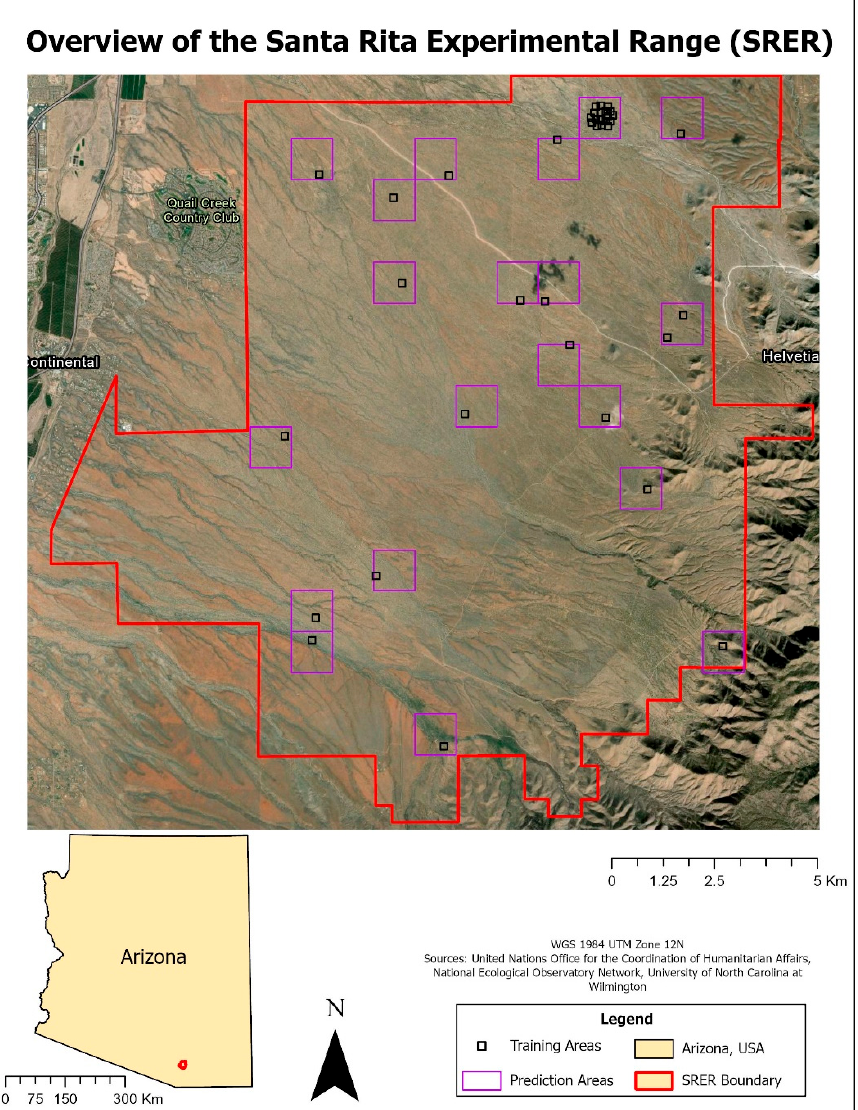
Figure 1. Santa Rita Experimental Range (SRER). AOP flight box is outlined in red, with prediction areas outlined in purple and training areas outlined in black [25, 27, 30,].